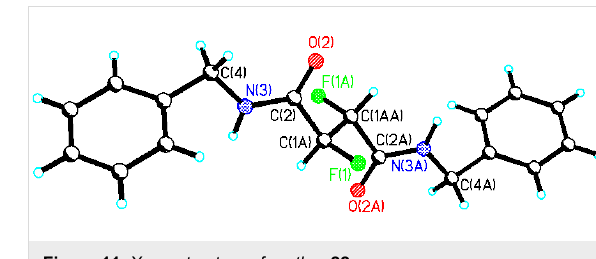
Figure 11: X-ray structure of erythro - 22 .